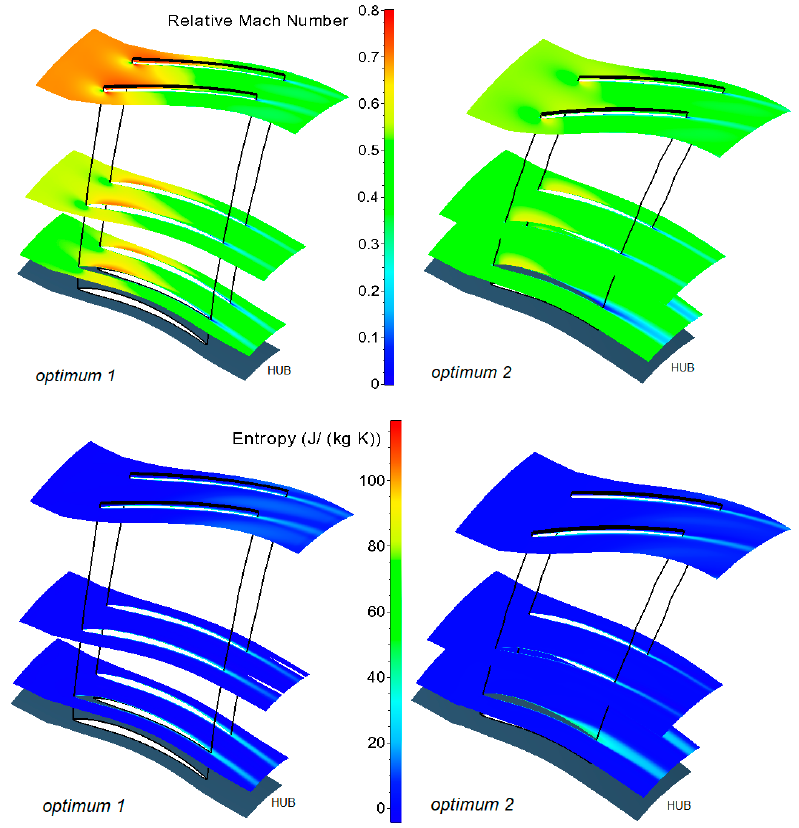
Figure 13. Relative Mach and entropy contours for two different optimums.